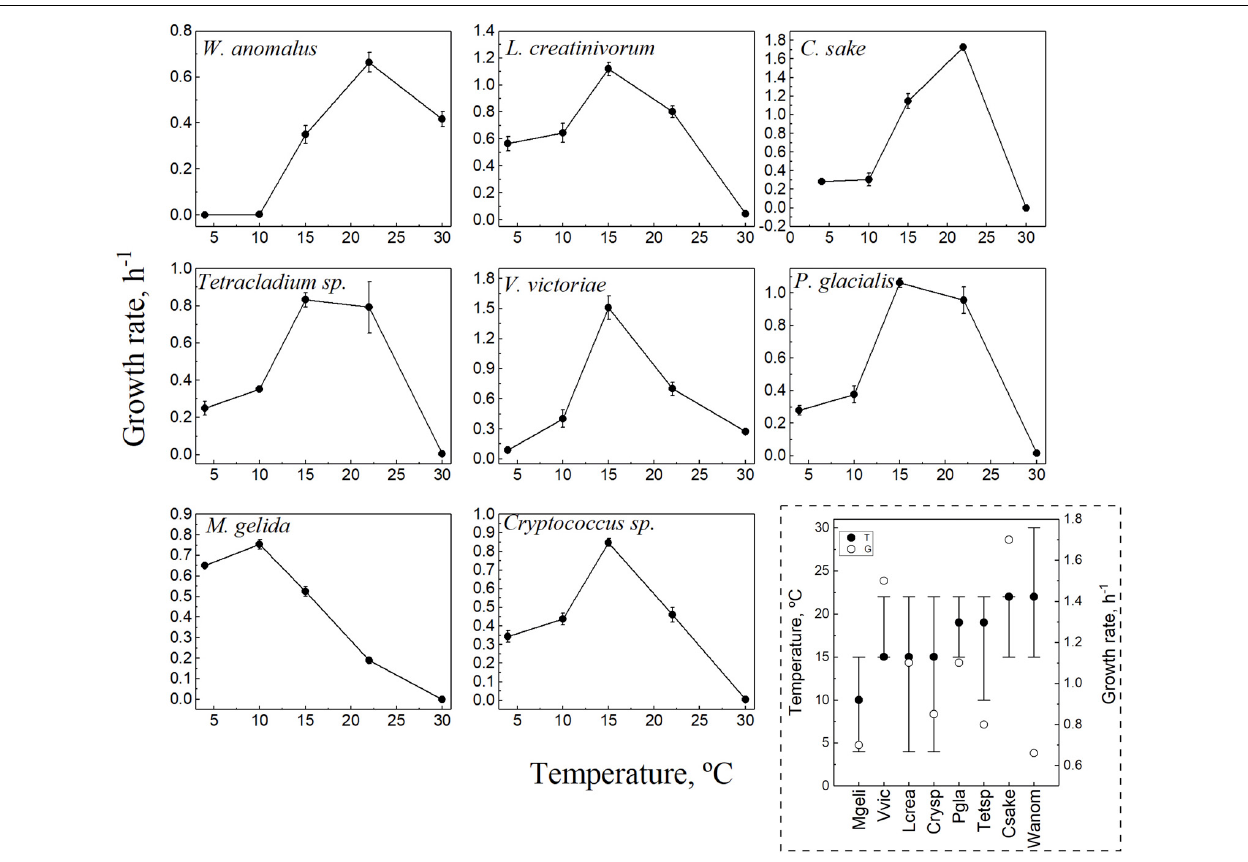
FIGURE 1 | Growth parameters of yeast species. Yeasts were cultivated in YM media at temperatures from 4 to 30 ◦ C, and growth was monitored by DO600 until reaching the stationary phase. All curves were performed in triplicate. The growth rate was calculated from the exponential phase of each curve and plotted vs. the temperature. In the discontinuous square, a resume of growth parameters for each yeast is shown: optimal temperature for growth (filled circles), highest growth rate (empty circles) and the range of temperature for growth (lines). Yeast species: Crysp, Cryptococcus sp.; Csake, C. sake ; Lcrea, L. creatinivorum ; Mgeli, M. gelida ; Pgla, P. glacialis ; Tetsp, Tetracladium sp.; Vvic, V. victoriae ; Wanom, W. anomalus